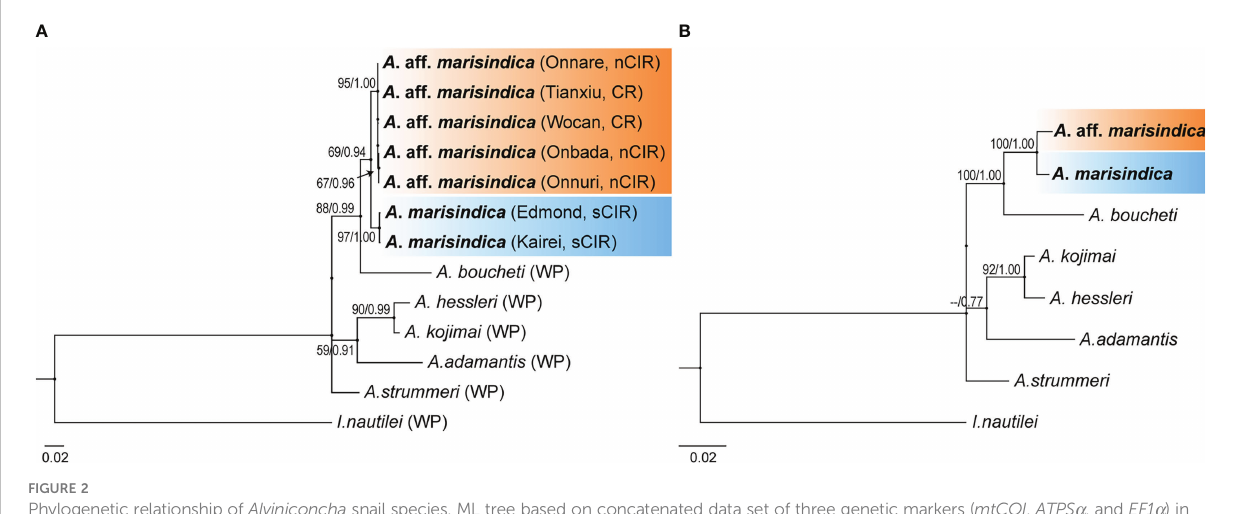
FIGURE 2 Phylogenetic relationship of Alviniconcha snail species. ML tree based on concatenated data set of three genetic markers ( mtCOI , ATPS a , and EF1 a ) in (A) and eight genetic markers (mt COI , mt 12S rRNA, mt 16S rRNA, ATPS a , EF1 a , H3 , 18S rRNA, and 28S rRNA) in (B) . The bootstrap value (>50%) and posterior probabilities (>0.70) estimated from ML and BI analyses, respectively, are shown on the nodes. (A) Vent habitats are enclosed in parentheses next to each taxon name.